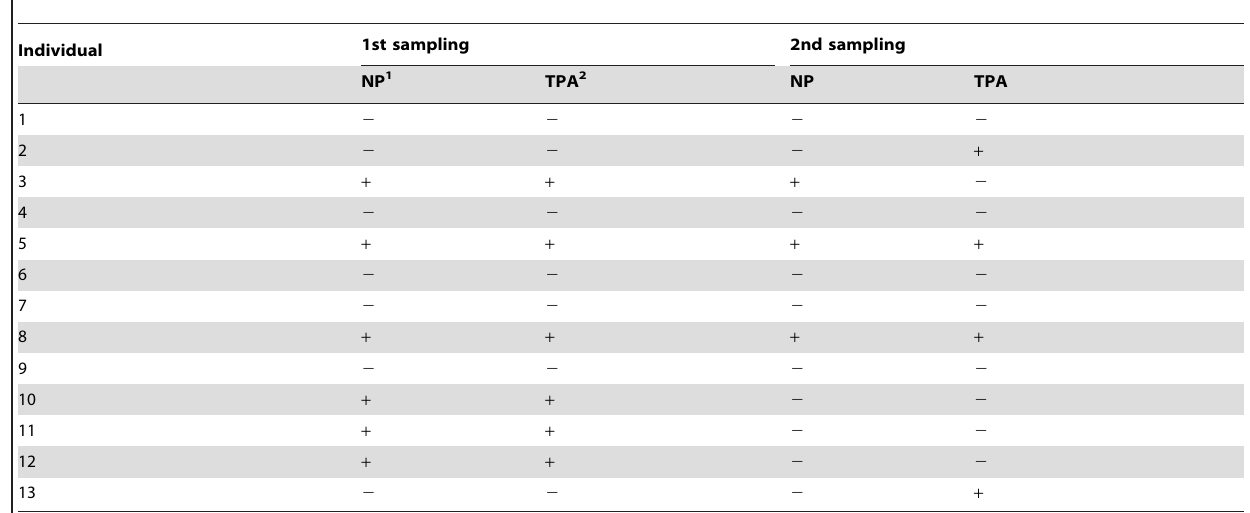
Table 2. Infection status of subjects dependent on PCR method of swab samples taken at 24 h and 16 days.